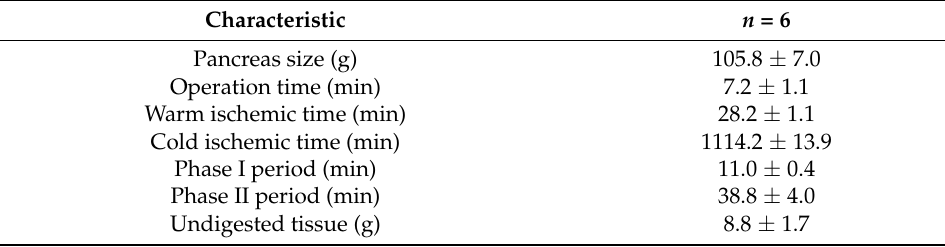
Table 1. The characteristics of the tissue and procedures.